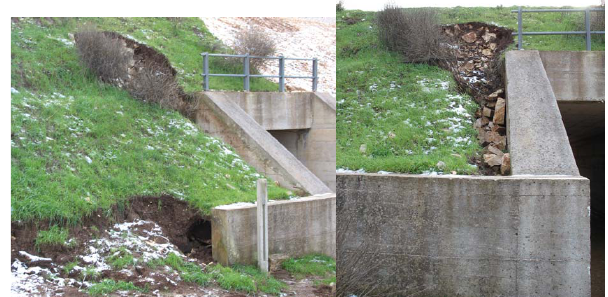
Figure 17 – Photos of the concentrated erosion pipe at the contact between the wall of the 4 concrete conduit and the soil material. 5 Fig. 17. Photos of the concentrated erosion pipe at the contact be- tween the wall of the concrete conduit and the soil material.